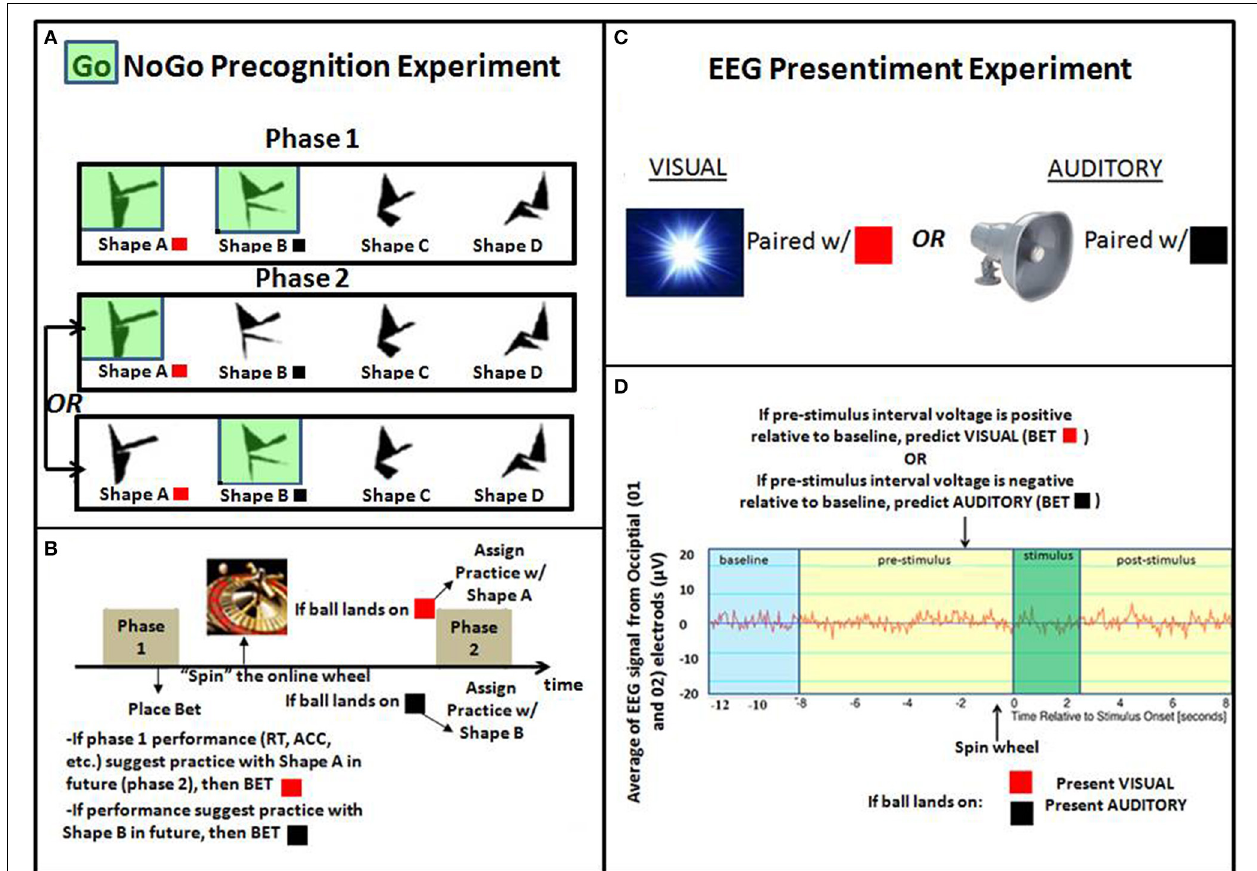
FIGURE 1 | The left side displays the experimental design of two-phase Go-NoGo precognition task: (A) 4 random polygons are displayed individually on screen for 1s at a time. Shape A is (arbitrarilly) associated with RED, and Shape B is associated with BLACK. During phase 1 all participants are told to press the spacebar only when shape A and B appear (the “Go” shapes, colored green), and withhold responses to shapes C and D while these responses and reaction times are recorded. In phase 2, particpants only respond to one “Go” shape. As seen in (B) the phase 2 shape is determined by a roulette spin outcome 2 . As such, the precognitive influence of phase 2 practice on phase 1 performance (e.g., improved detection of the shape practiced in the future) would allow for a real-time